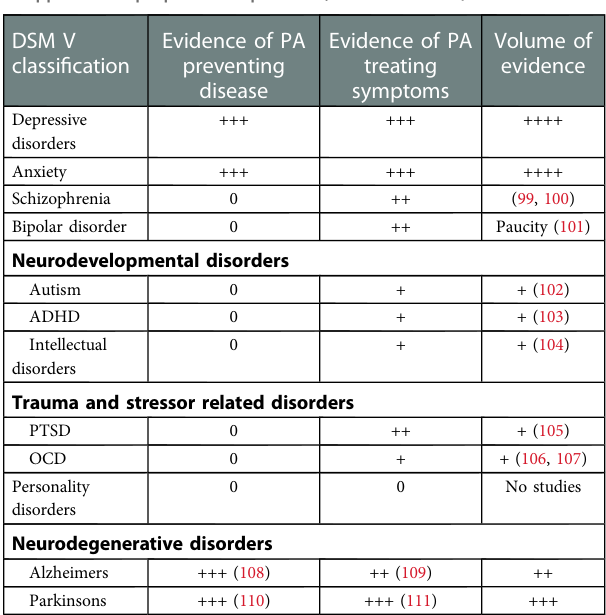
TABLE 1 Quantity of evidence for physical activity in fl uencing neuropsychiatric conditions (Symbols “ + ” , “ ++ ” , “ +++ ” and “ ++++ ” refer to approximate proportional quantities, relative to